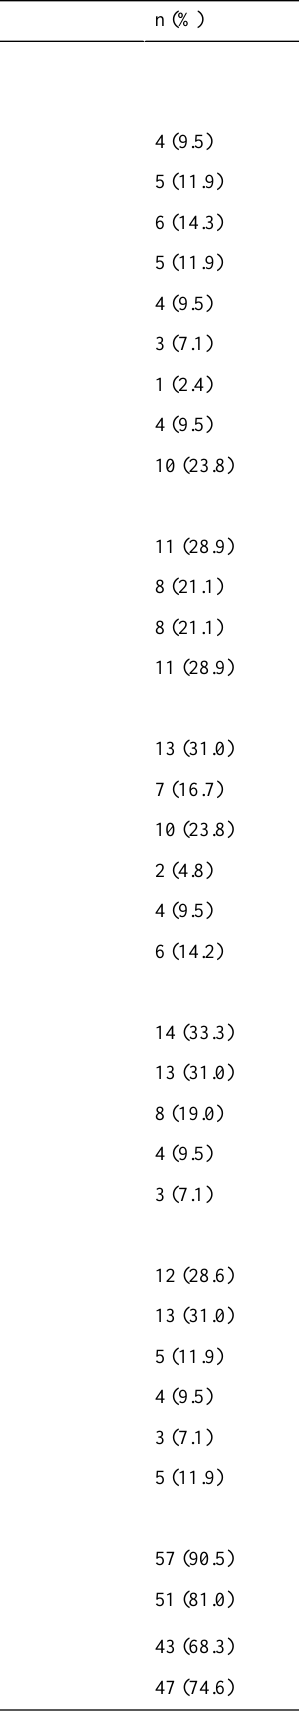
Table 2. Children Eating Well smartphone app prototype usage (note: some column percentages do not add up to 100% due to